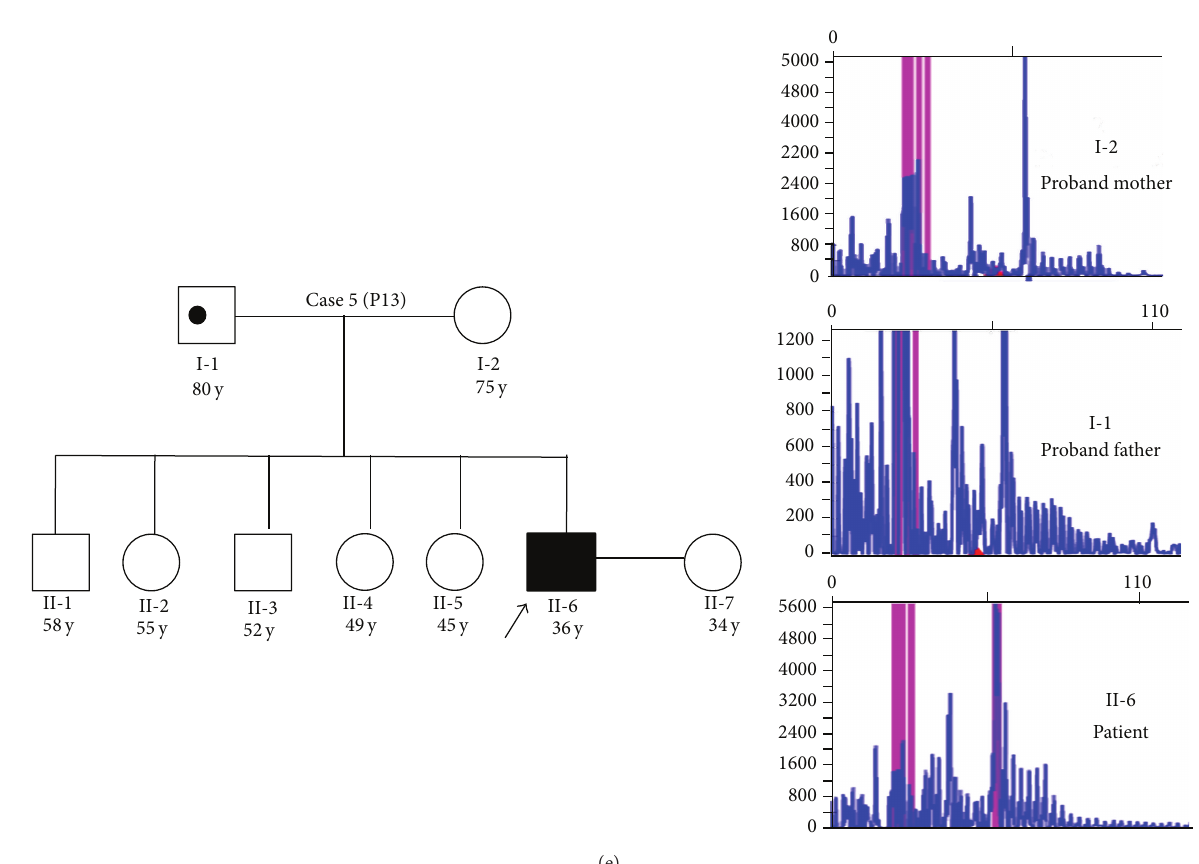
Figure 1: (a) Case 1 (P2): I-1, I-2, II-2, and II-3 were proband’s father, mother, younger sister, and younger brother, and II-1 was DM1 patient. Square = male; circle = female; black symbol = patient (II-1); and black dots in symbols represent asymptomatic carriers (proband’s mother, I-2, and younger sister, II-2). (b) Case 2 (P7): I-2, III-2, and III-3 all were normal and II-1, II-3, II-4, and III-1 were asymptomatic carriers. (c)